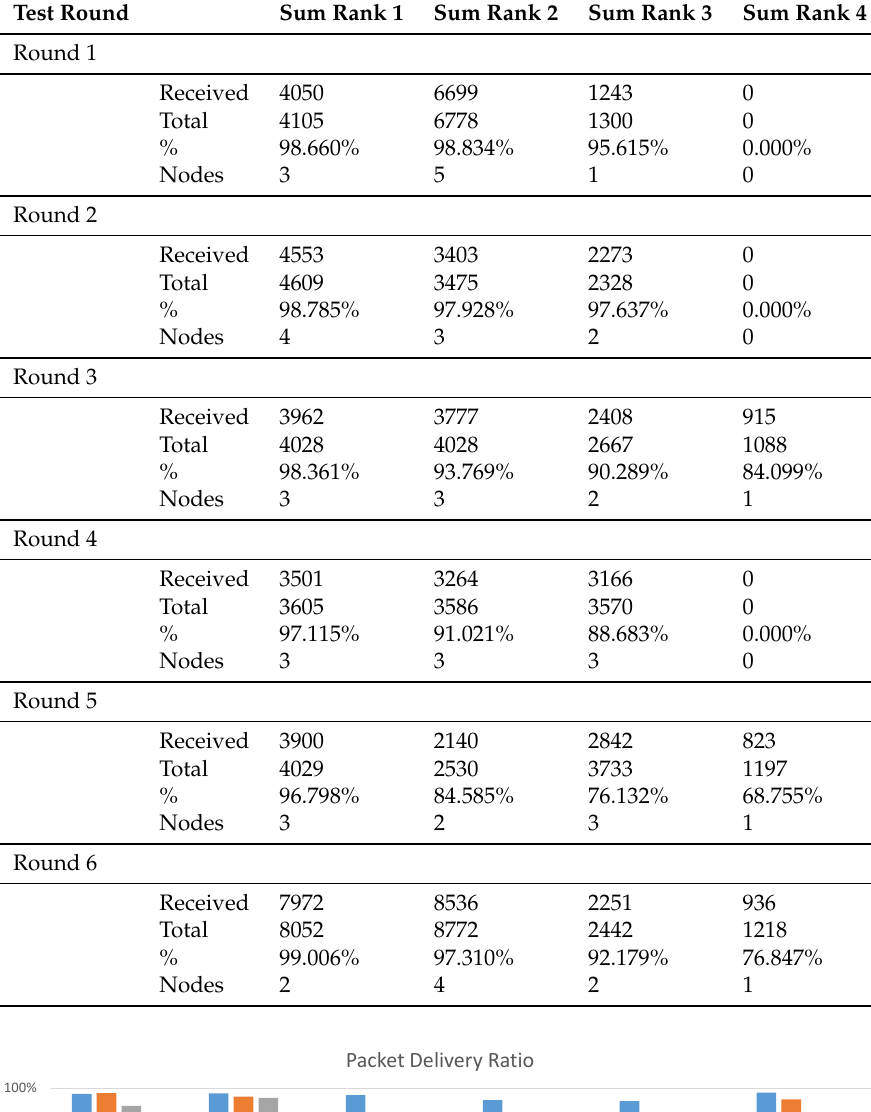
Table 8. Combined PDR attending to node rank.